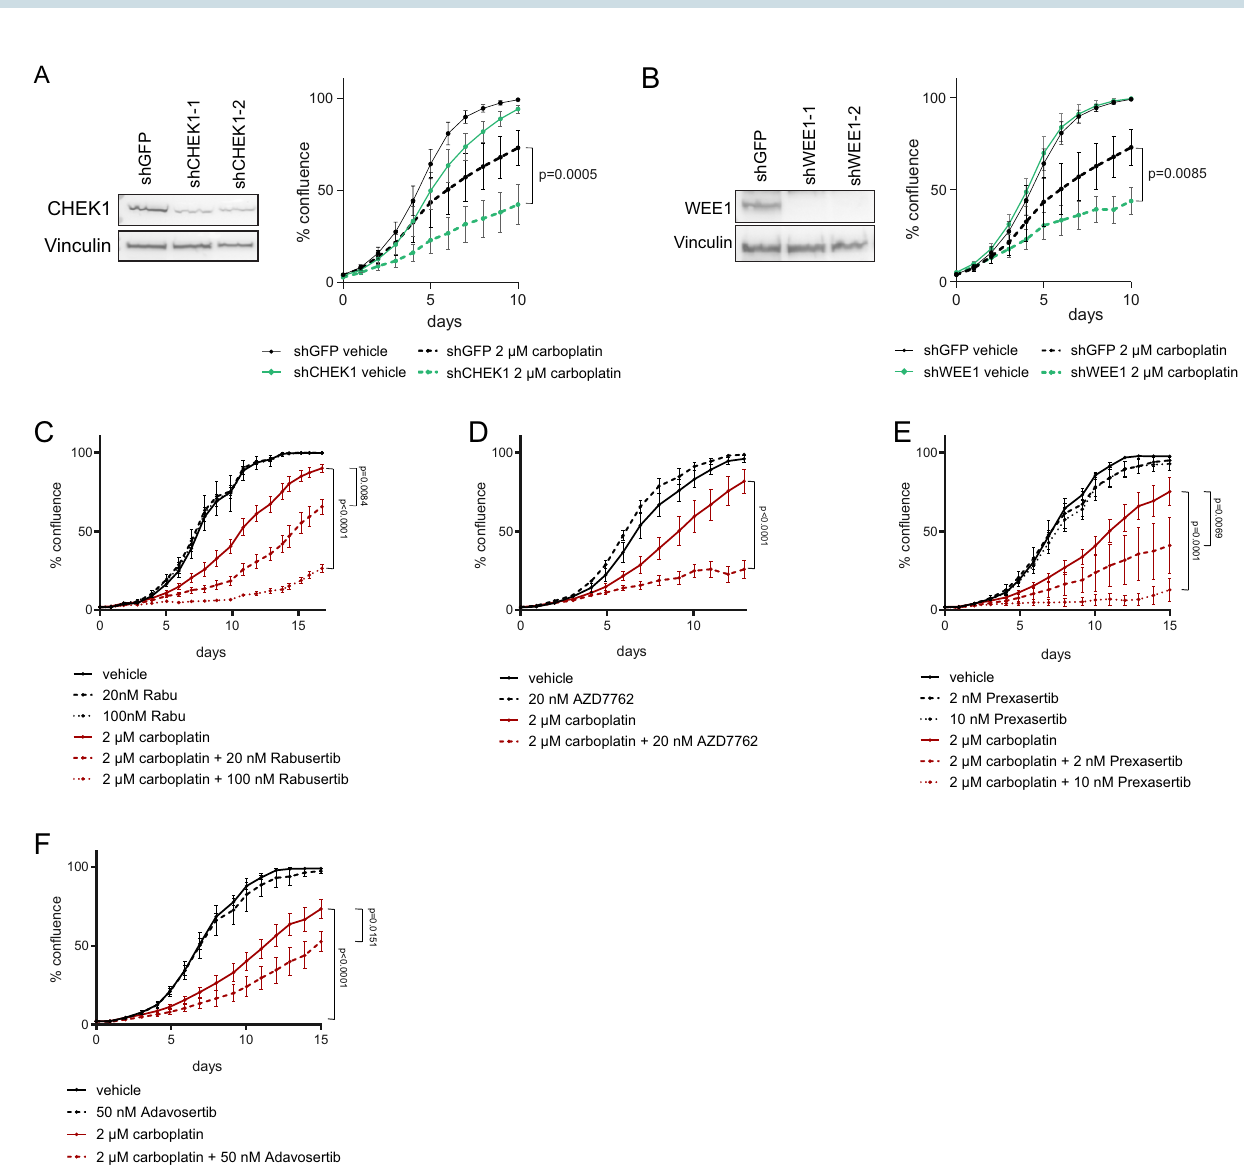
Figure 4. Inhibition of CHEK1 and WEE1 re-sensitize carboplatin-resistant 468-R cells. The growth of 468-R cells was analyzed by an Incucyte imaging system. ( A,B ) CHEK1 or WEE1 knockdown in 468-R cells expressing shRNAs against GFP , CHEK1 or WEE1 were confirmed by immunoblotting (left). Uncropped blots are shown in Supplementary Figure S4. The growth of the indicated cells treated with vehicle or 2 µM carboplatin for 10 days (right). Data are shown as the mean of two independent shRNAs targeting CHEK1 or WEE1 . P values were calculated by two-way ANOVA with Geisser–Greenhouse and Dunnett’s corrections. Data are shown as Mean ± SEM. N = 7. ( C–F ) 468-R cells treated for up to 17 days with 2 µM carboplatin alone or in combination with CHEK1 inhibitor rabusertib (N = 3) ( C ), CHEK1/2 inhibitor AZD7762 (N = 4) ( D ), CHEK1 inhibitor prexasertib (N = 5) ( E ), or WEE1 inhibitor adavosertib (N = 5) ( F ). P values were calculated by two-way ANOVA with Geisser–Greenhouse and Dunnett’s corrections. Data are shown as Mean ±